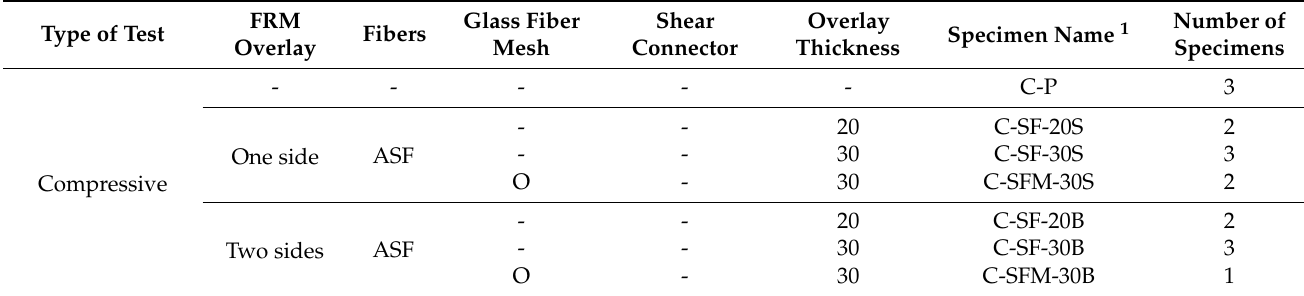
Table 1. Test program and specimens.